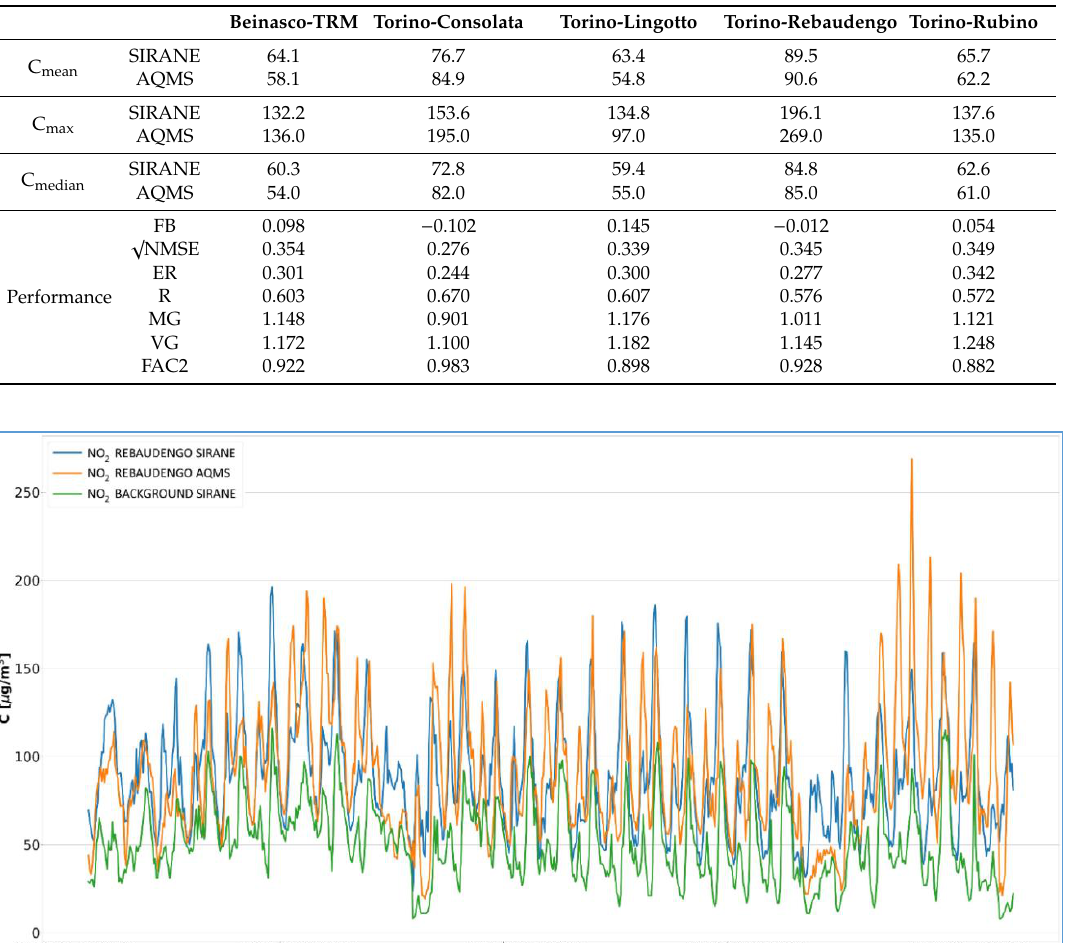
Table 3. Comparison of mean, max and median concentration and performance parameters of SIRANE against AQMS monitored values.